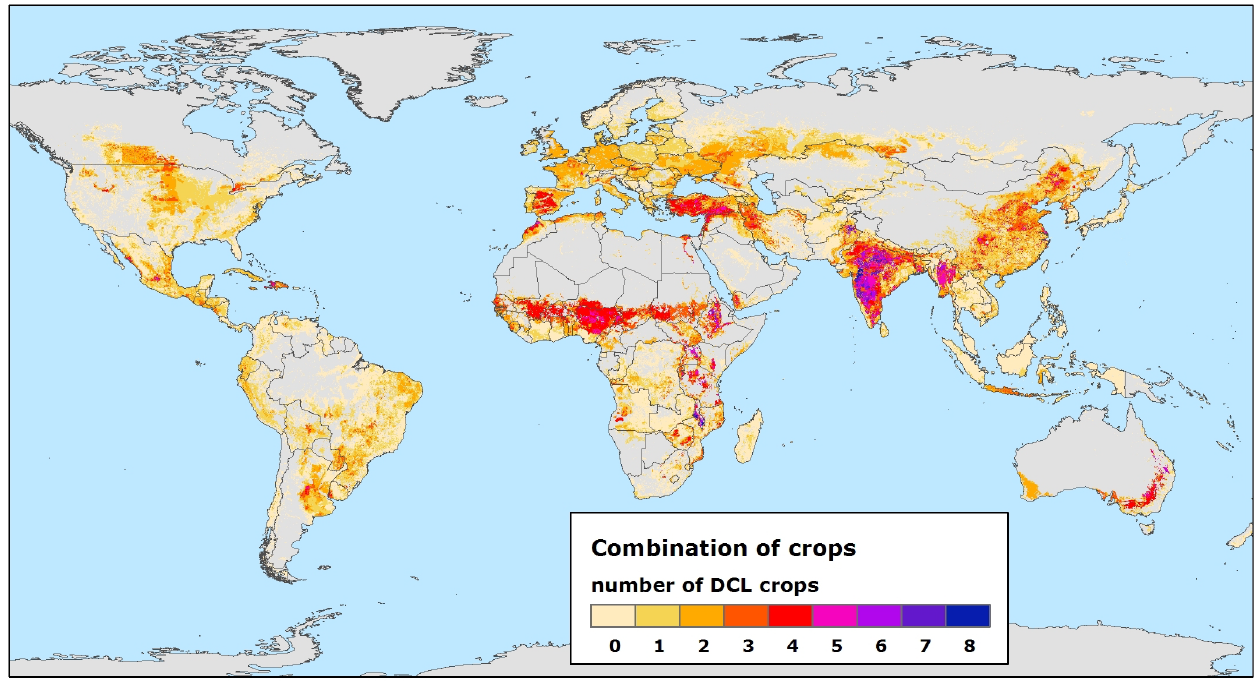
Figure 4. The DCL crops present a number of opportunities for bringing multiple technology options among different crops to the same geographic area. The map shows several core areas where 3 to 5 or more DCL crops are grown together.